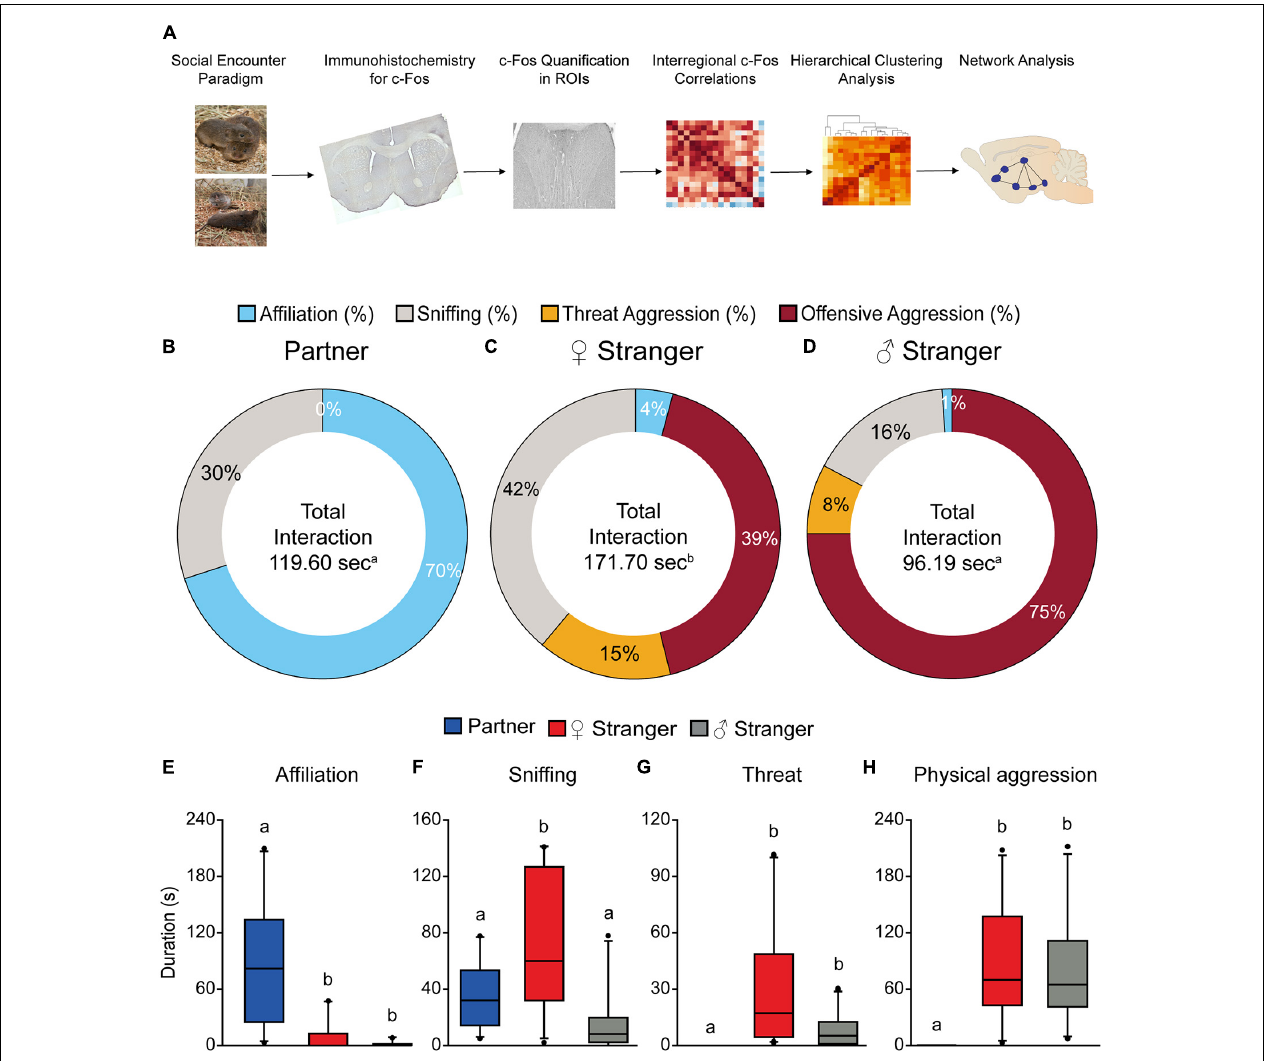
FIGURE 1 | Schematic of experimental timeline (A) . Male prairie voles paired for 2 weeks induced selective affiliation toward a partner and aggression toward opposite and same sex stranger conspecifics. Male voles displayed significantly higher levels of affiliation compared to the other two social exposures (B,E) . Male voles spent significantly more time interacting with the opposite-sex stranger (C) , as well as higher levels of sniffing compared to the partner and same sex stranger (F) . Male voles spent the least amount of time interacting with the same sex stranger (D) . Male voles displayed higher levels of threat aggression (G) and offensive aggression (H) toward both the opposite-sex and same sex stranger. Groups labeled with unique alphabetical letters differed significantly by post hoc SNK test in which a significant main effect was detected in the ANOVA ( p < 0.05). If groups share any letter, there was no significant difference between them. Thus, “a” was different from “b,” but “ab” was equal to both “a” and “b” ( n = 10 per